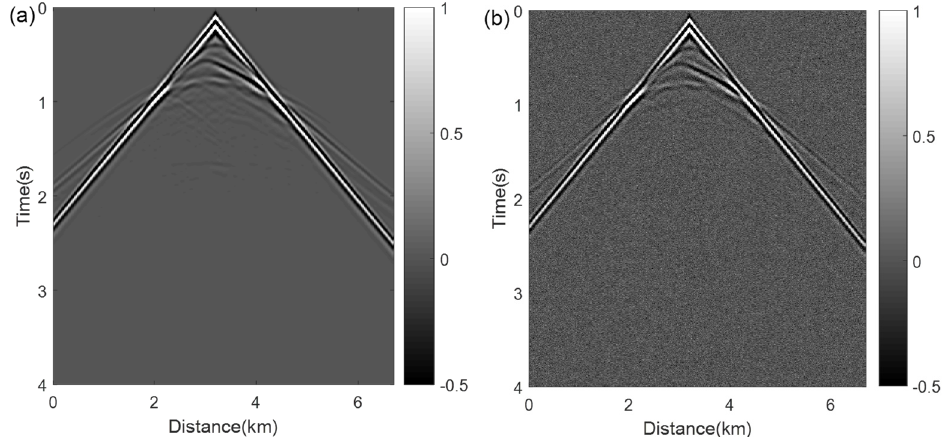
Figure 9. Noisy data used in this test. ( a ) Noise-free data. ( b ) Noisy data.